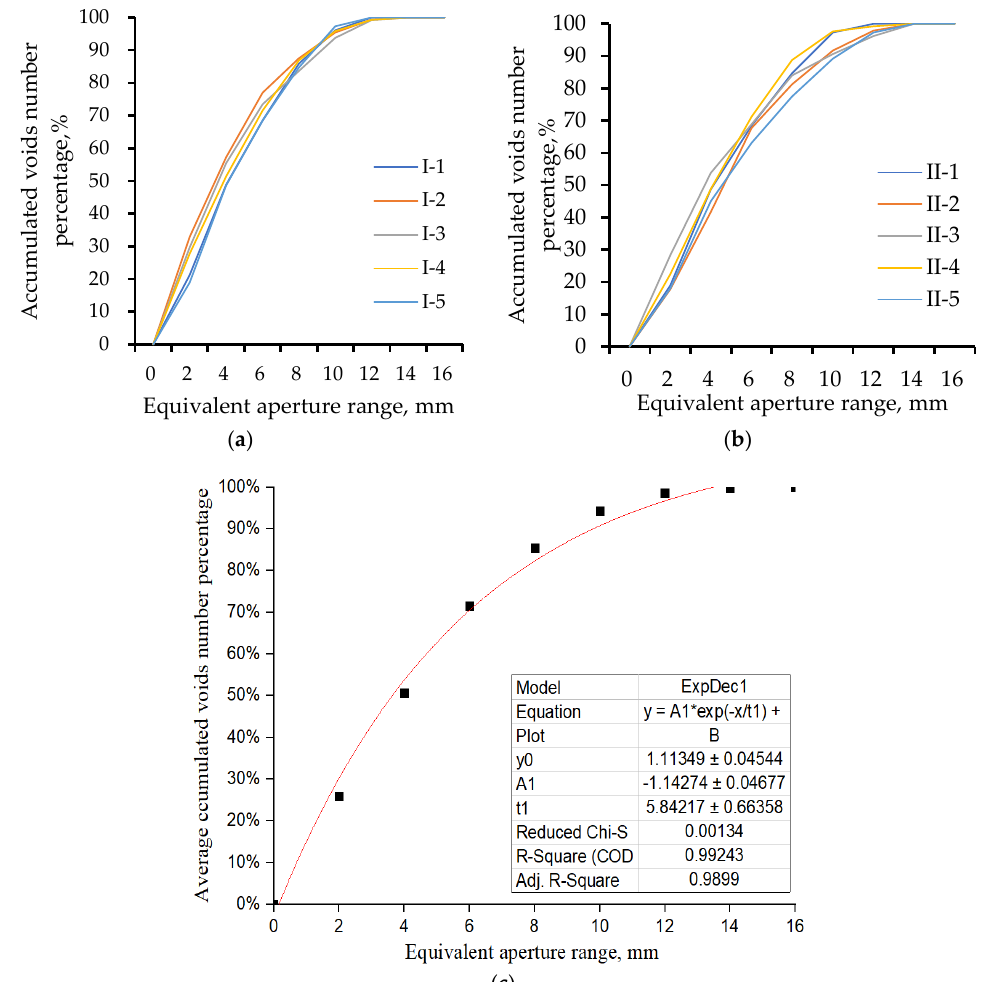
Figure 8. Relationship between accumulated number of voids and the equivalent aperture, ( a ) OGFC sample I, ( b ) OGFC sample II, ( c ) Average value of OGFC samples. sample I, ( b ) OGFC sample II, ( c ) Average value of OGFC